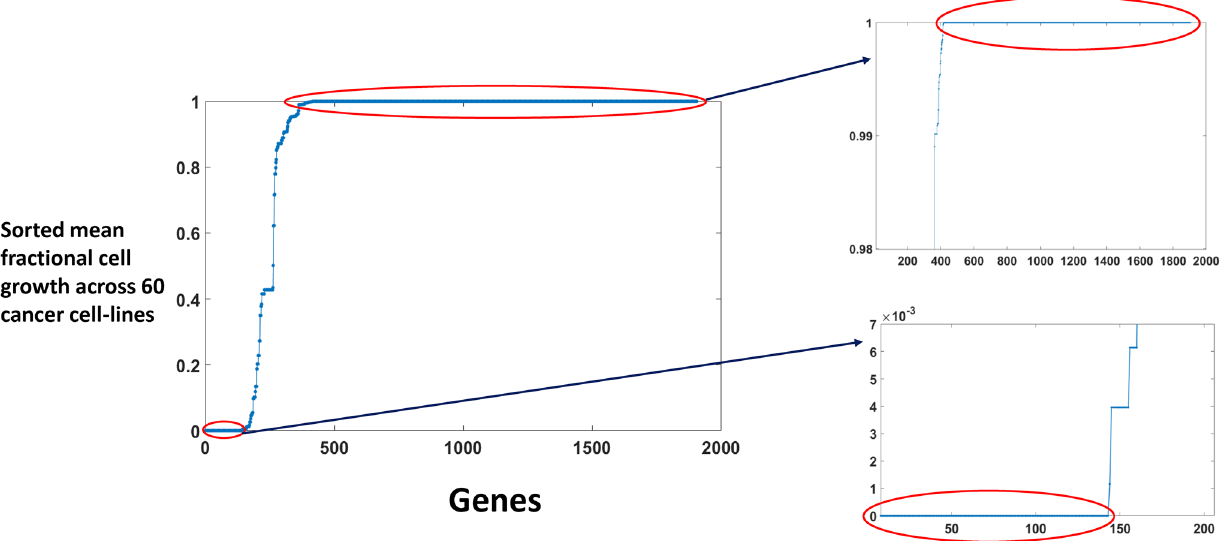
Figure 1. Gene knockout simulation result. Mean value of the fractional cell growth (FCG) across 60 cancer metabolic models for each individual of 1905 metabolic genes. The right lower panel represents the 143 genes which give very low growth rate after knocking out across all 60 cancer models (mean value < 10 − 6 s.d. < 1.2874 × 10 ) and the upper panel represents the 1488 genes which show no change in the growth rate after knocking out across all 60 cancer models (mean value > 0.99995 & s.d. < 3.2838 × 10